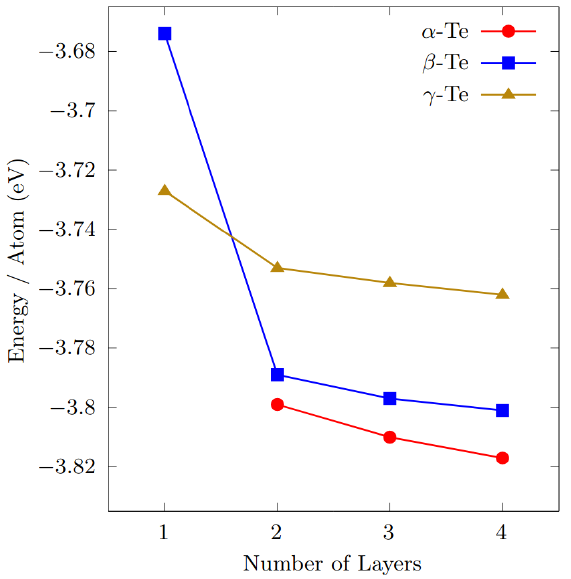
Figure 2. Total energy per atom (rescaled with respect to an isolated Te atom), for increasing number of layers, of the three studied phases. The γ -phase is the most stable in the ML configuration, while the α -phase is preferred for larger layer thicknesses. Note that the ML α -phase is